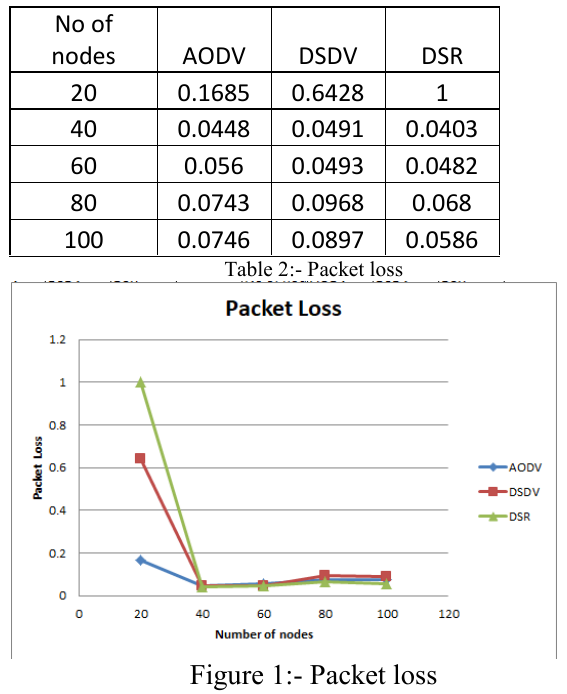
Table 1;- Constant packet size of 512Mb with variable number of nodes